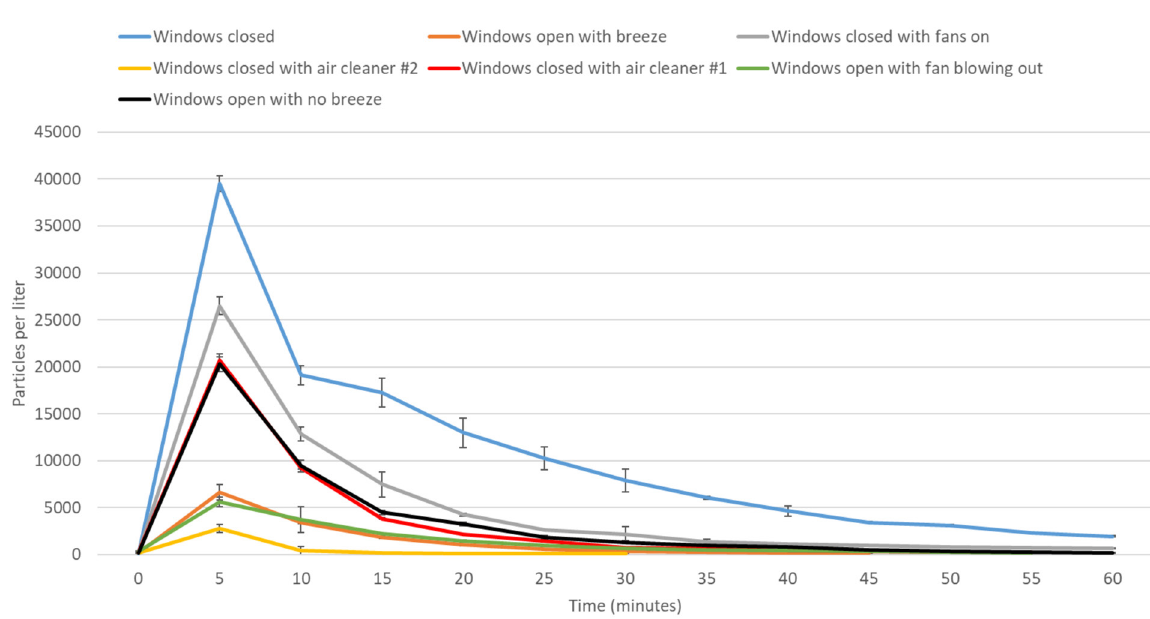
Figure 4 . Clearance of 5% sodium chloride solution aerosol particles (1 to 10 µm diameter) in a kitchen with windows closed versus with several different interventions to improve ventilation. Fans included an overhead ceiling fan, stove fan without external ventilation, and the central air conditioning fan on in continuous mode. The aerosol particles were released over 15 seconds. Average results for 3 experiments are shown. Error bars represent standard